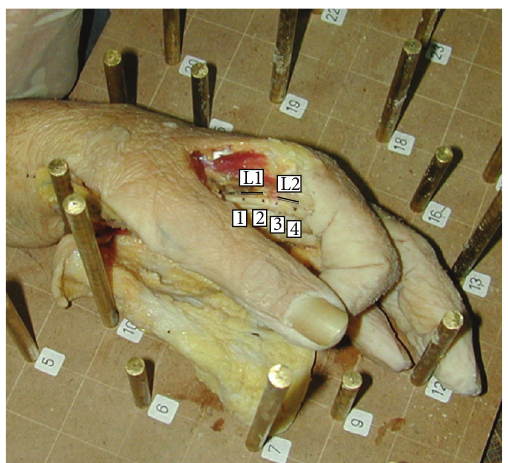
Figure 1: Four points were marked on the flexor tendon consecu- tively using a surgical pen and two lines were created as line 1 (points 1 and 2) and line 2 (points 3 and 4). L1: line 1, L2: line 2.